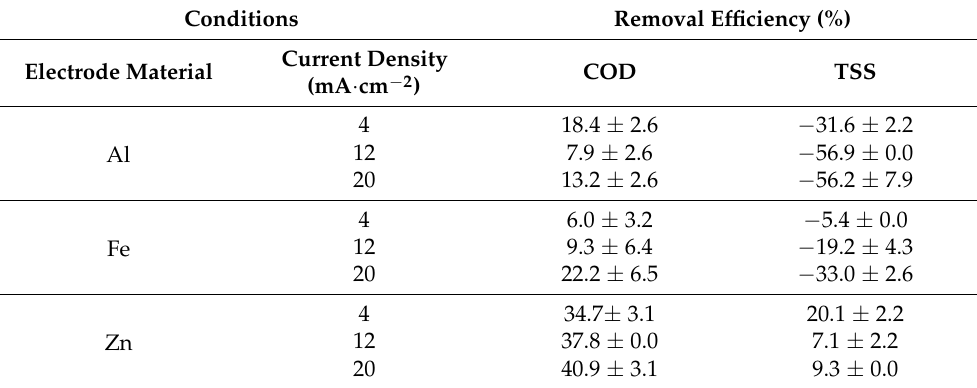
Table 1. Removal efficiencies (%) of chemical oxygen demand (COD) and total suspended solids (TSS) obtained after electrocoagulation with different electrode materials and current densities. Conditions Removal Efficiency (%) Current Electrode Material